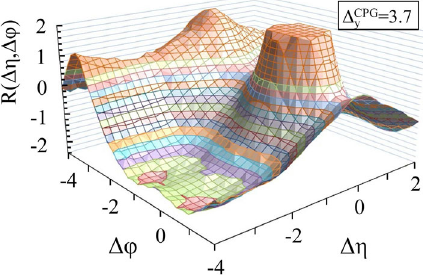
Fig. 5 The R (Δη,Δϕ) distribution simulated with FANSY 2.0 CPG (“weak”) at | Δη | ≤ 4 for high-multiplicity events